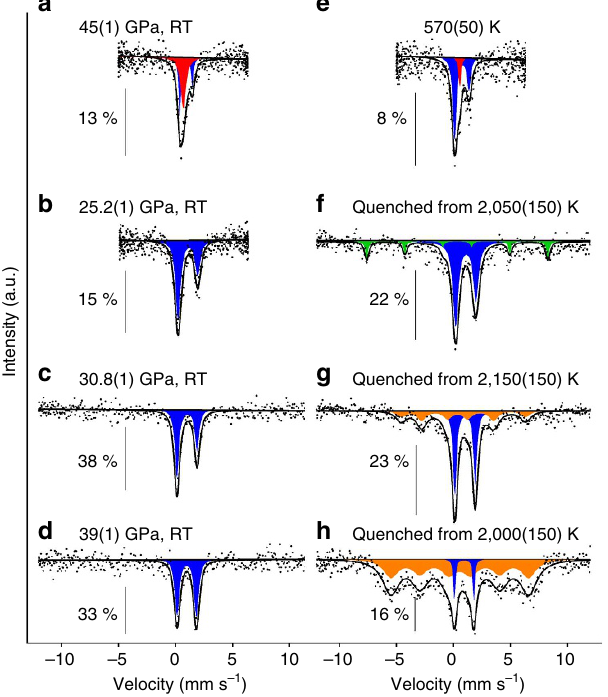
Figure 4 | Selected synchrotron Mo¨ssbauer spectra from high P-T treatment of FeCO 3 . ( a – d ) Spectra collected at the indicated pressures at room temperature before heating; ( e – h ) Spectra collected during or after heating at the indicated temperatures. Subspectra are shaded as follows: blue doublet—high-spin ferrous iron, red singlet—low-spin ferrous iron; green sextet— a -Fe 2 O 3 and orange sextet—HP-Fe 3 O 4 (Supplementary Fig. 5). Note that in a the intensity (amount) of high-spin ferrous iron increases with increasing temperature. The appearance of HP-Fe 3 O 4 in g and h is the result of progressive decomposition of FeCO 3 upon melting at high pressure. Continuous lines are fitted with the full transmission integral (Methods section). Percentages on the left of each spectrum indicate the relative